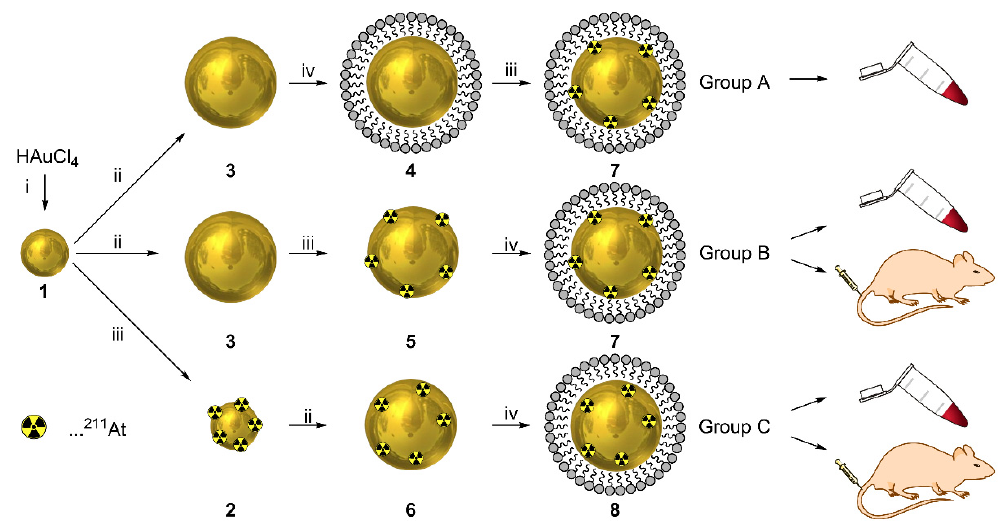
Figure 2. Study design and 211 At-AuNPs preparation. The stability of Group A was investigated in serum only; Group B and Group C were investigated both in serum and in mice. Reaction conditions: (i) sodium citrate at 80 ◦ C for 1 h, (ii) slow addition of HAuCl 4 at 80 ◦ C over 6 min and additional reaction time for 1 h, (iii) addition of 211 At in chloroform at room temperature and stirred for 20 min, (iv) addition of HS-PEG 5000 in water at room temperature and stirred for 25 min. (1) 1st generation citrate-stabilized AuNPs, (2) 1st generation citrate-stabilized [ 211 At]AuNPs, (3) 2nd generation citrate-stabilized AuNPs, (4) 2nd generation HS-PEG 5000 -coated AuNPs, (5) 2nd generation citrate-stabilized [ 211 At]AuNPs, (6) 2nd generation citrate-stabilized embedded [ 211 At]AuNPs, (7) 2nd generation HS-PEG 5000 -coated [ 211 At]AuNPs, (8) 2nd generation HS-PEG 5000 -coated embedded [ 211 At]AuNPs.